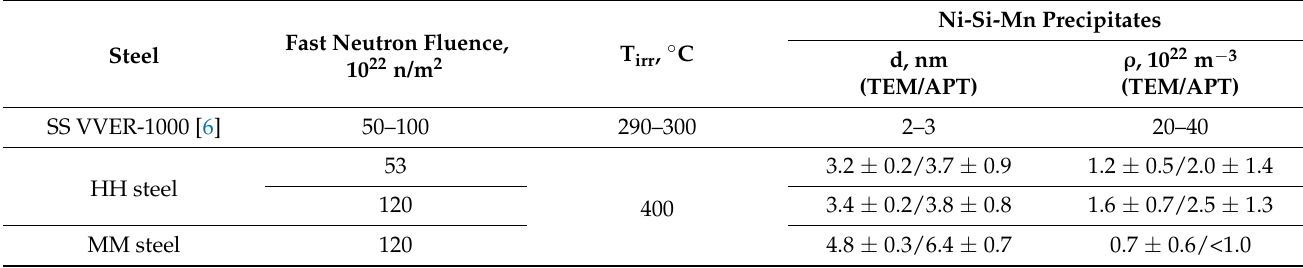
Table 3. Parameters of detected Ni-Si-Mn precipitates in MM and HH steels after neutron irradiation up to various fluences.